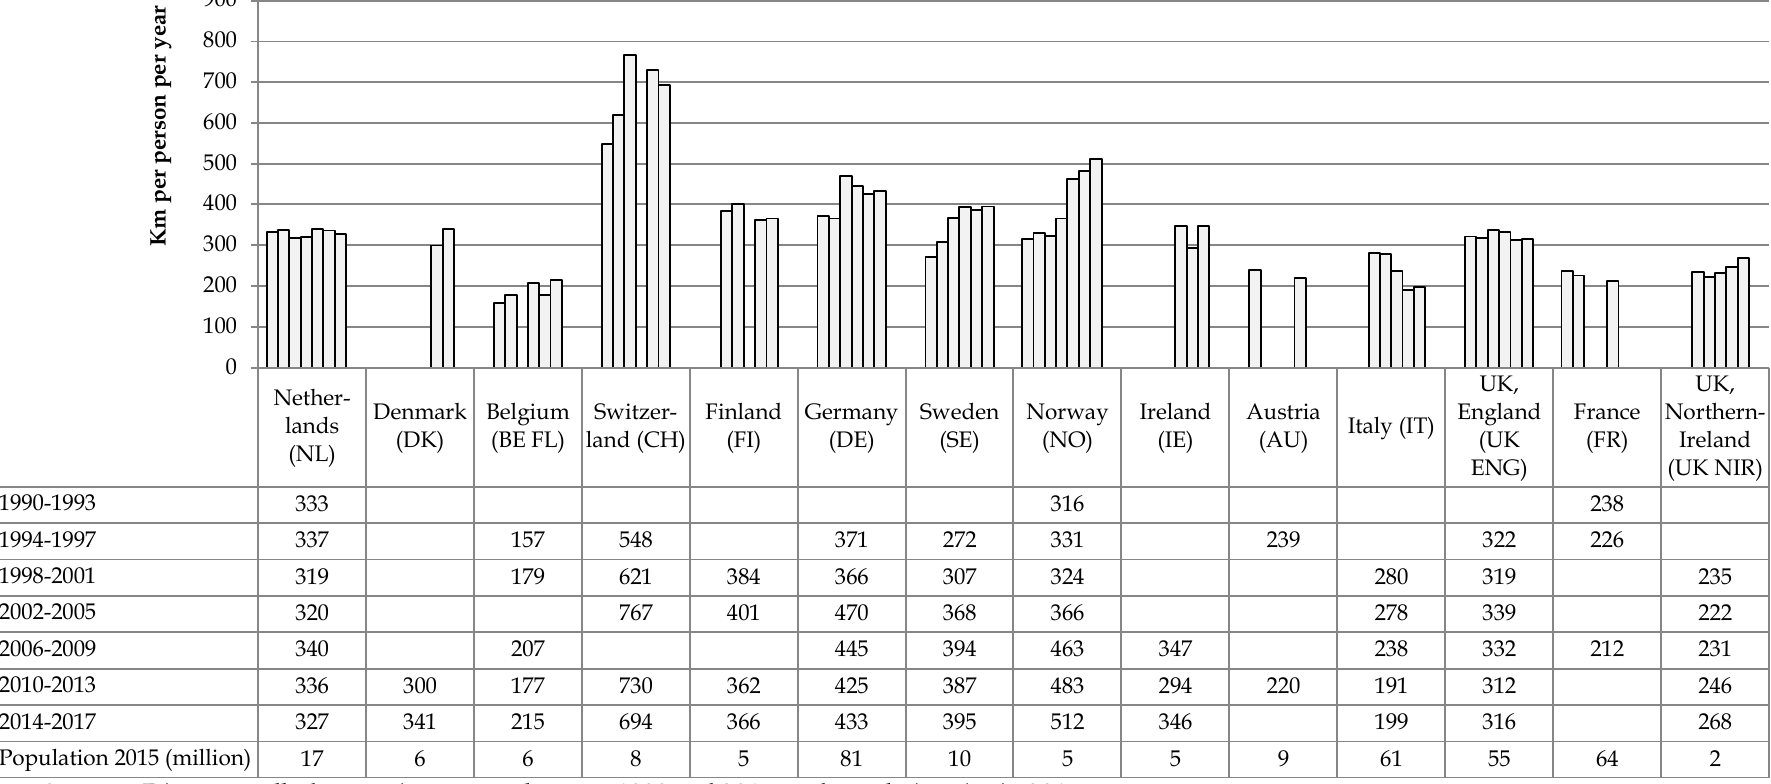
Figure 8. Distance walked per capita per year between 1990 and 2017, and population size in